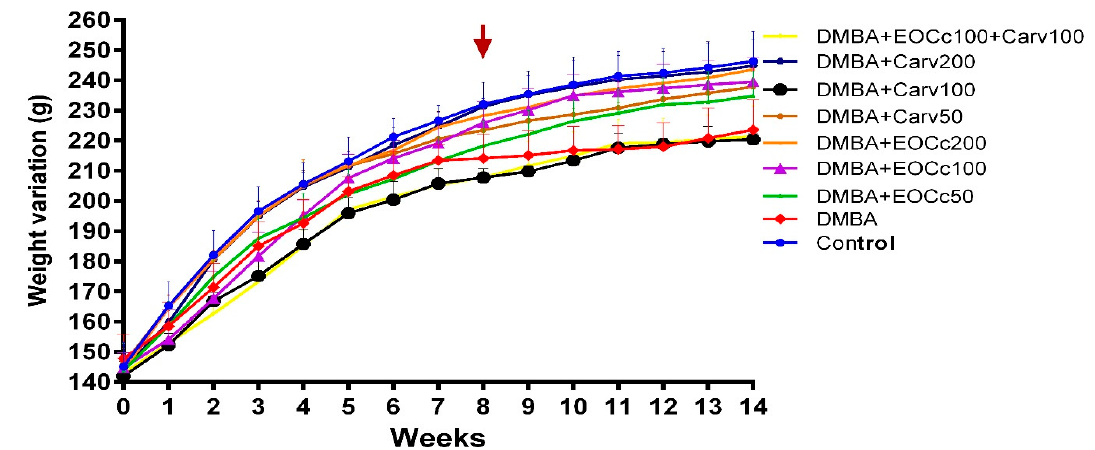
Figure 4. Variation of body weight in rats with DMBA-induced breast cancer and treated with EOCc and carvacrol for 14 weeks. Each point represents ± SEM of six animals. Significant difference from the DMBA group at 8 weeks ( p < 0.05). One-way ANOVA followed by a post hoc (brown narrow).